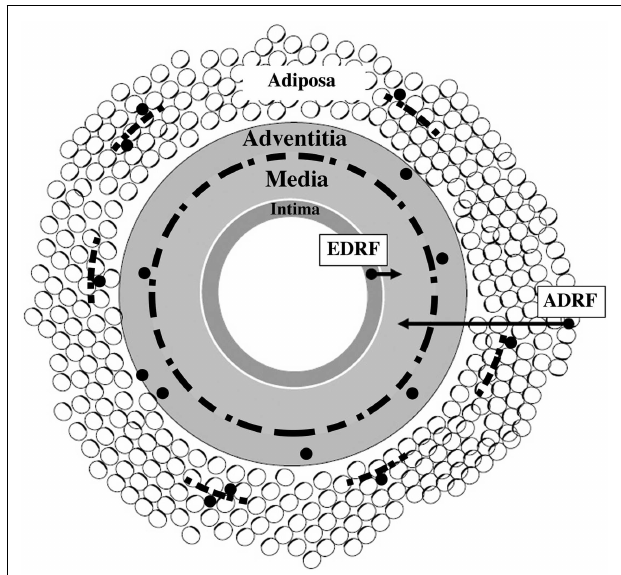
FIGURE 1 | Schematic presentation of vascular wall composed of four tissue coats ( tunicae ): intima, media, adventitia, and adiposa . Arrows show that tunica media is a target for at least two vasorelaxing factors, endothelium-derived relaxing factor (EDRF) and adipocyte-derived relaxing factor (ADRF), respectively. Discontinuous black line positioned at the adventitia–media border illustrates perivascular nerves. Small-sized discontinuous black lines located in tunica adiposa indicate adipose nerves. Black granules (except those linked to arrows) illustrate immune cells – their association with nerves and adipocytes is also depicted. Modified from Ref.